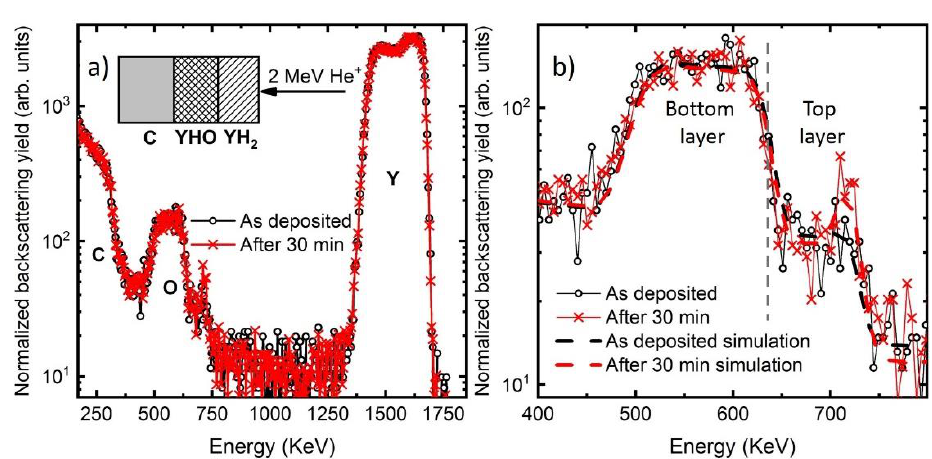
Fig. 1. RBS spectra (a) and zoom-in in the region associated with O signals (b) of the bilayer film taken as deposited (black open circles) and after 30 min in HV (red crosses). Black and red dashed lines show fit done using SIMNRA. The vertical dashed grey line indicates the interface between the two